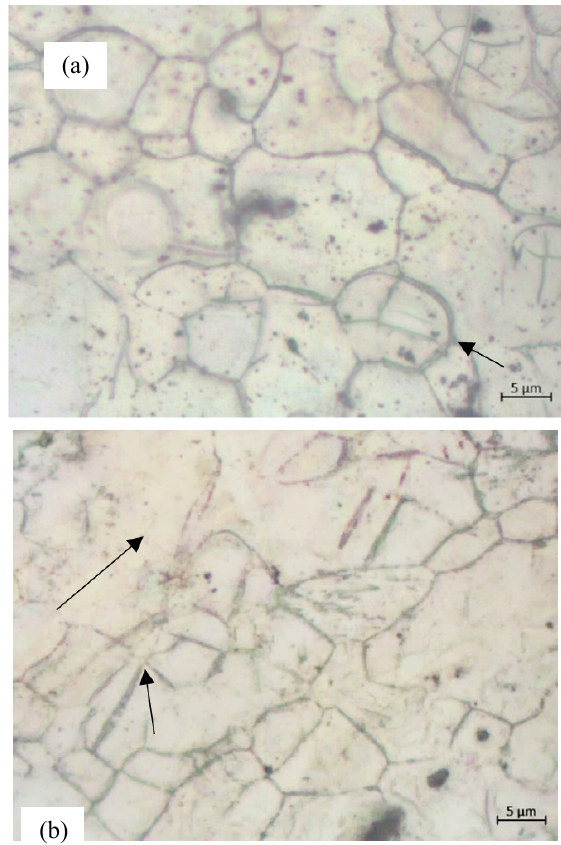
Figure 8. Change of microstructural observation on (a) Transverse surface section (b) Longitudinal surface section in LCF condition at a stress amplitude of 0.006 mm/mm